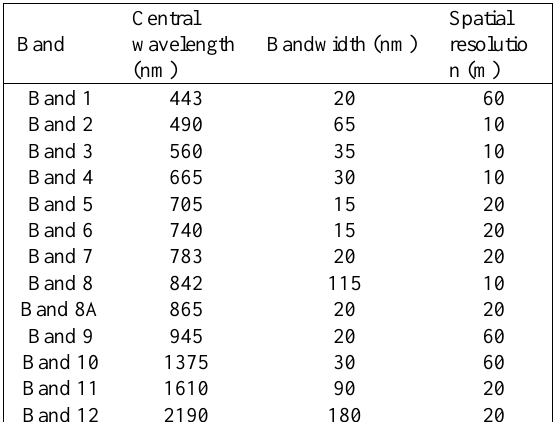
Table 1. Specifications of Sentinel 2 bands provided by ESA (European Space Agency (ESA), 2015) Images covering different phenological stages of the vegetation were used. Initially images from every season and every month were evaluated in order to optimize the multi-temporal